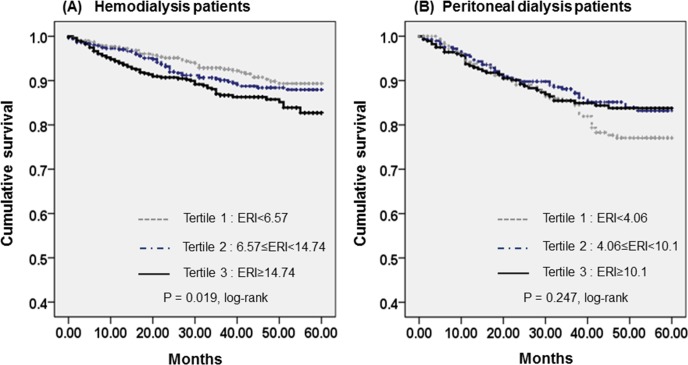
Kaplan-Meier plot of patient survival by tertiles of erythropoietin resistance index in (A) hemodialysis and (B) peritoneal dialysis patients.